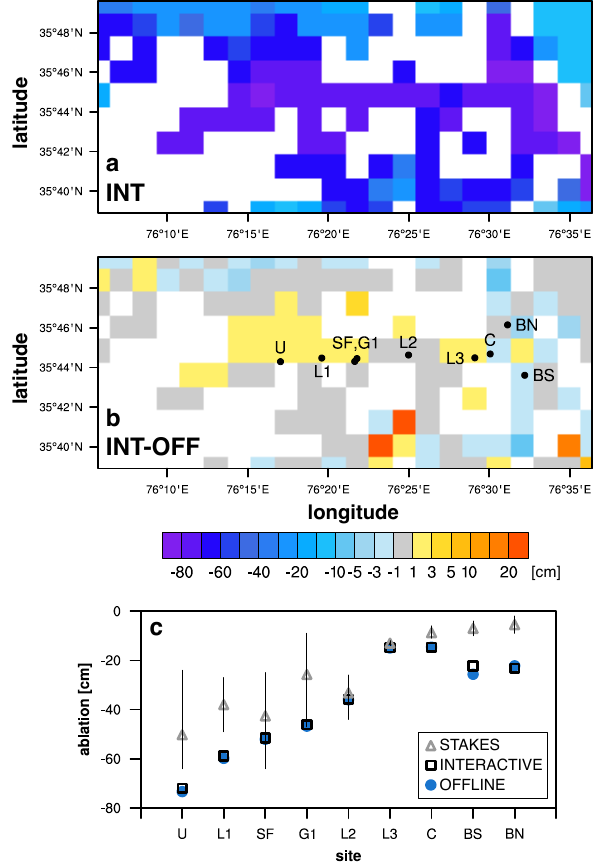
Fig. 4. (a) Total and (b) INT-OFF surface height change between 1–15 July 2004, in the vicinity of the main tongue of the Baltoro glacier. Stake site and transect locations shown in (b) , with ad- ditional information provided in Table 3. White grid cells corre- spond to non-glaciated area. (c) Measured mean ablation (triangles) at stake locations, with range of observed values denoted by bars. Simulated INT (OFF) ablation shown by black squares (blue cir-